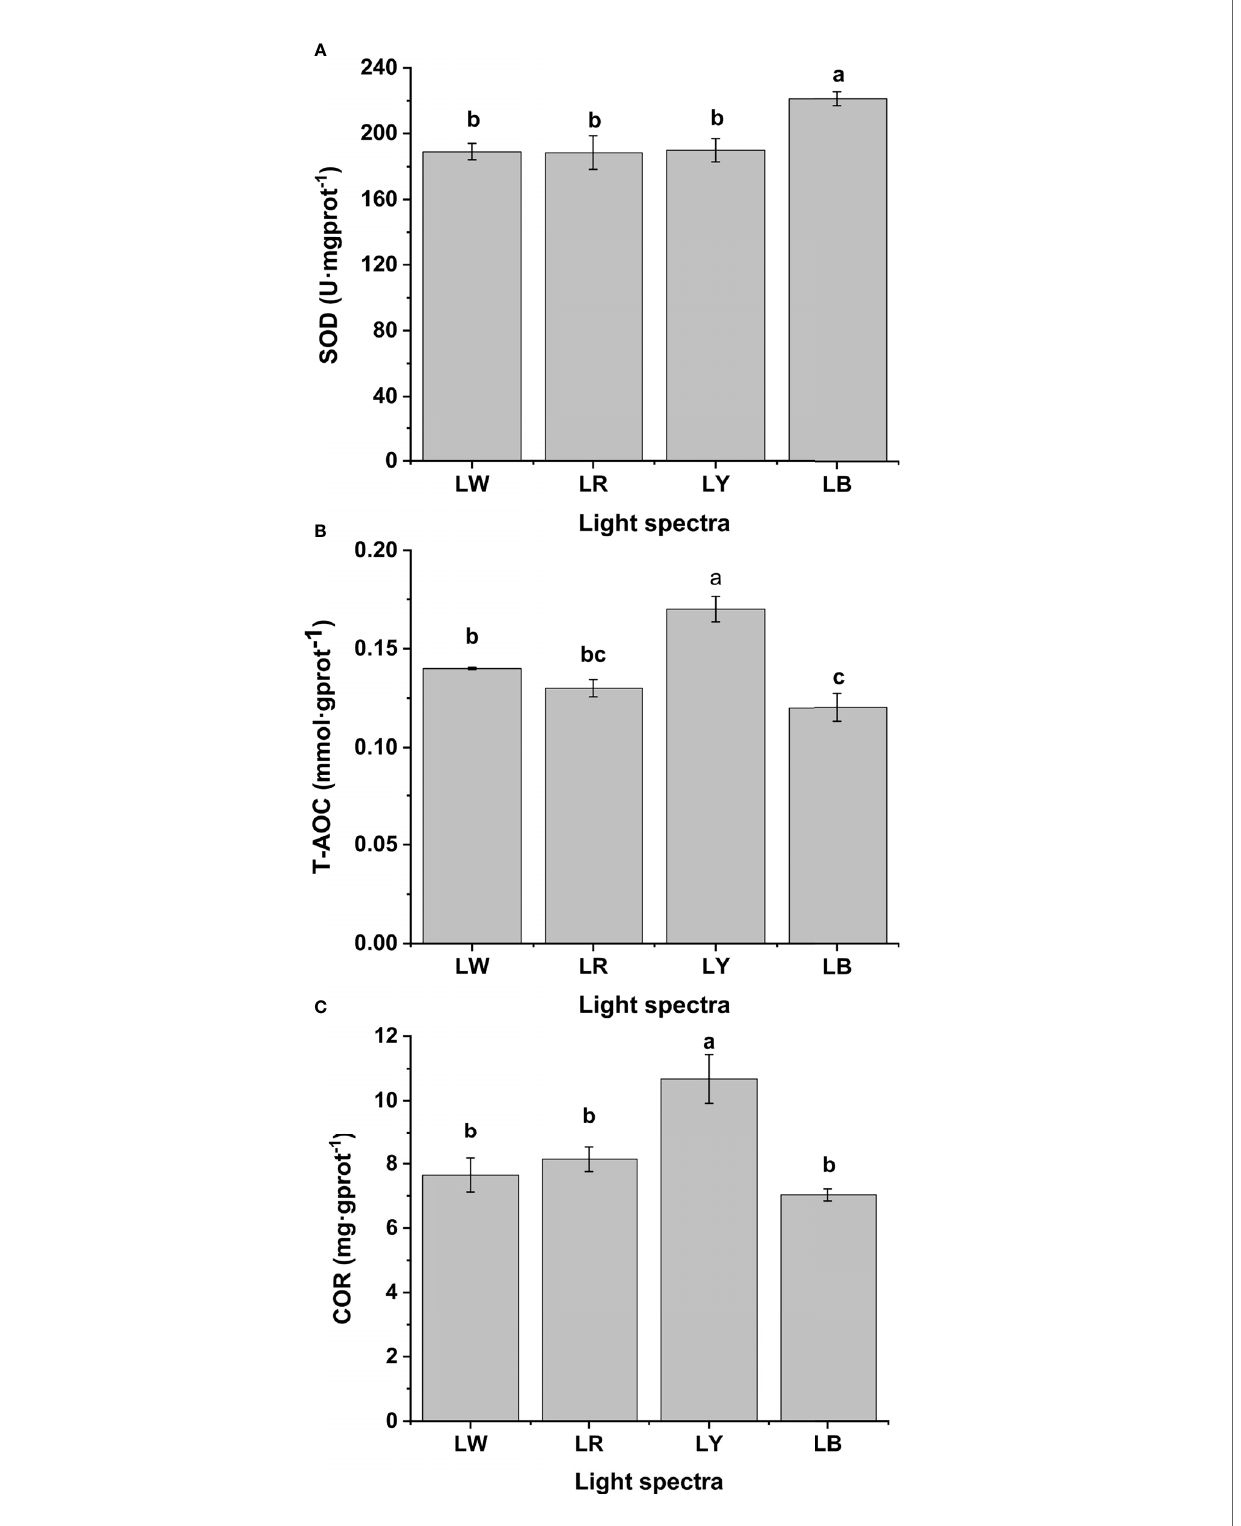
FIGURE 2 | Related non-speci fi c immune enzyme activities of GIFT tilapia juveniles cultured under different light spectra. (A) The superoxide dismutase (SOD) activities of GIFT tilapia juveniles under four light spectra. (B) The total antioxidant capacity (T-AOC) content of GIFT tilapia juveniles under four light spectra. (C) The cortisol (COR) content of GIFT tilapia juveniles under four light spectra. Different letters implies statistical differences (p <